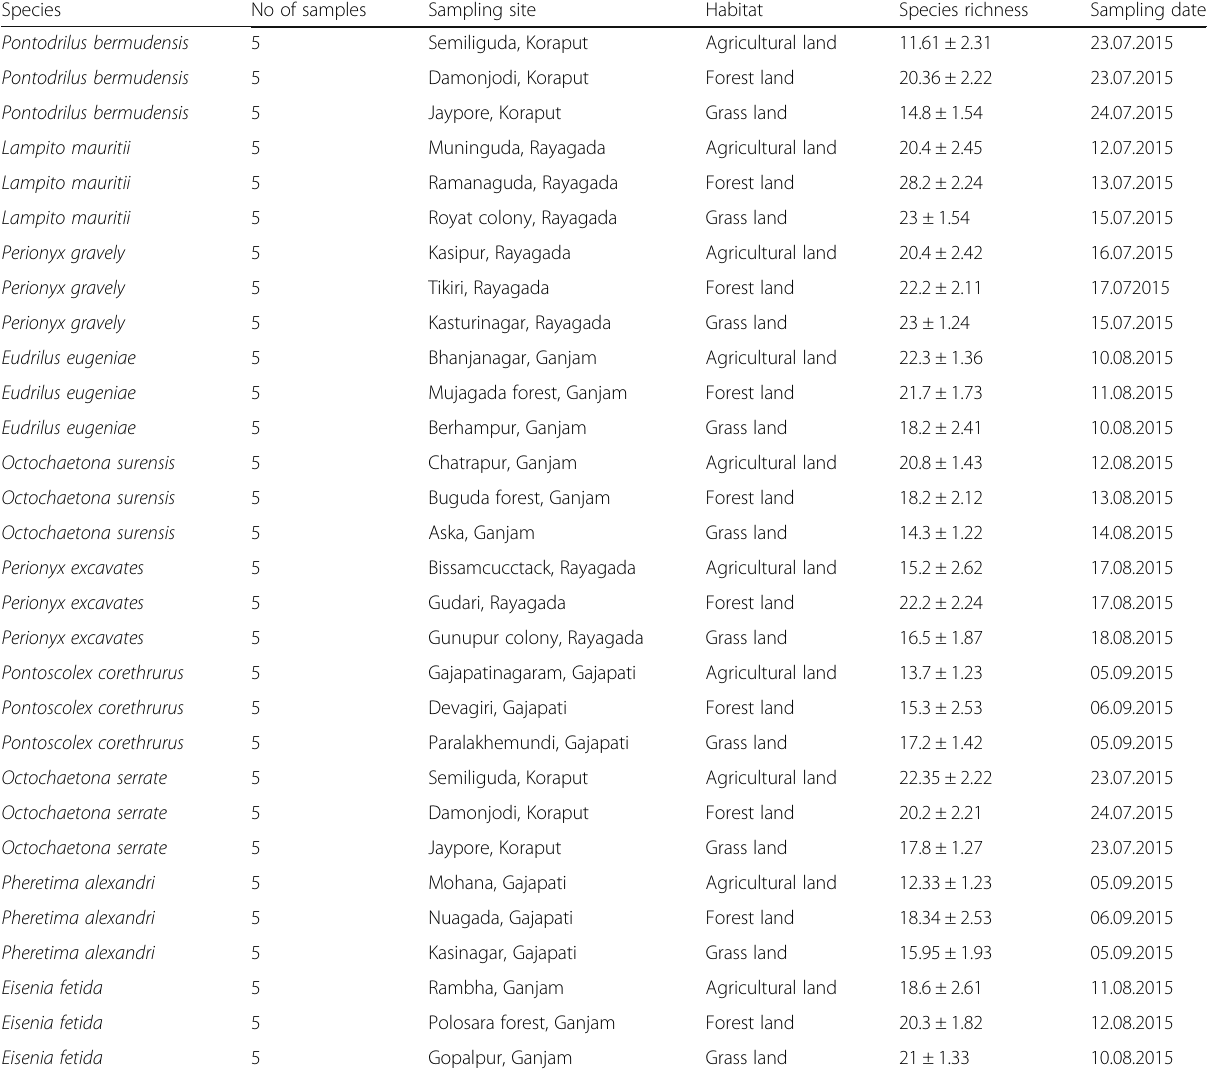
Table 7 Name of the species with sampling sites and habitat types Species No of